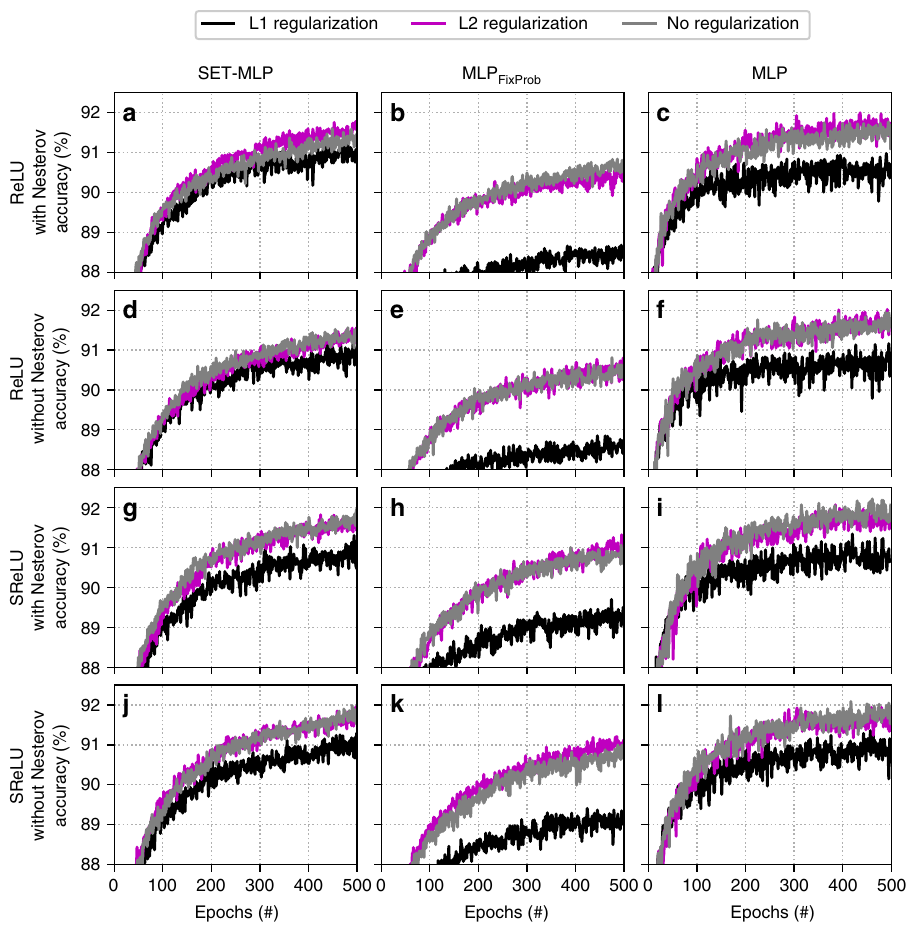
Fig. 6 Models accuracy using three weights regularization techniques on the Fashion-MNIST dataset. All models have been trained with stochastic gradient descent, having the same hyper-parameters, number of hidden layers (i.e. three), and number of hidden neurons per layer (i.e. 1000). a – c use ReLU activation function for the hidden neurons and Nesterov momentum; d – f use ReLU activation function without Nesterov momentum; g – i use SReLU activation function and Nesterov momentum; and j – l use SReLU activation function without Nesterov momentum. a , d , g , j present experiments with SET- MLP; b , e , h , k with MLP FixProb ; and c , f , i , l with